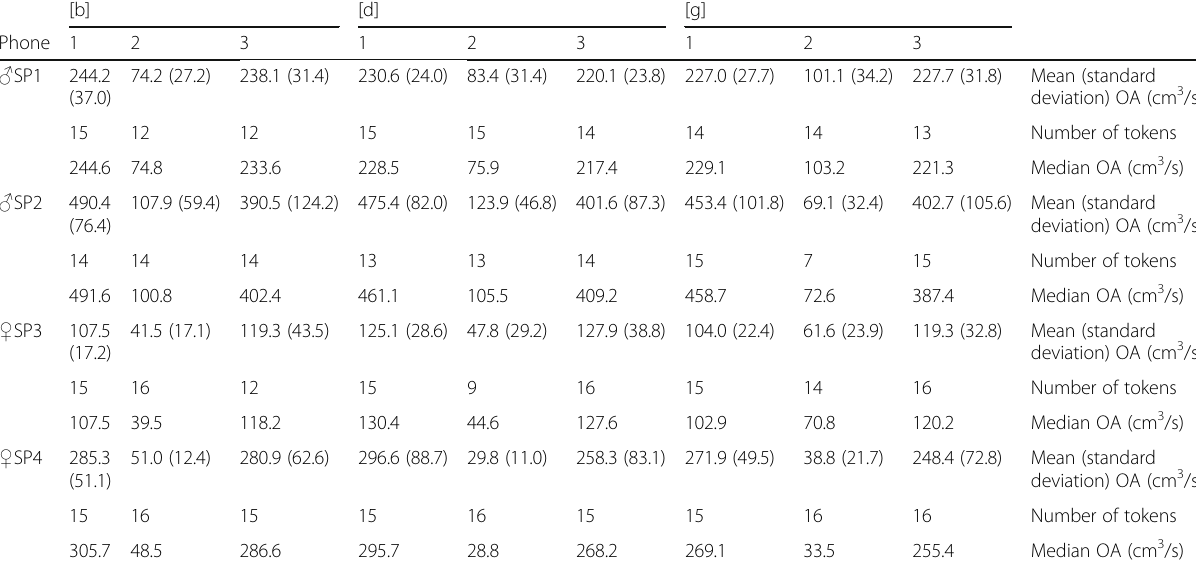
Table 7 Mean (standard deviation) absolute values (OA), number of tokens and median absolute values of oral airflow. Columns designated as (1) present values for a 20 ms window centred in the phone preceding the target stop; (2) a 10 ms window centred in the middle of the closure; (3) a 20 ms window centred in the phone after the target stop